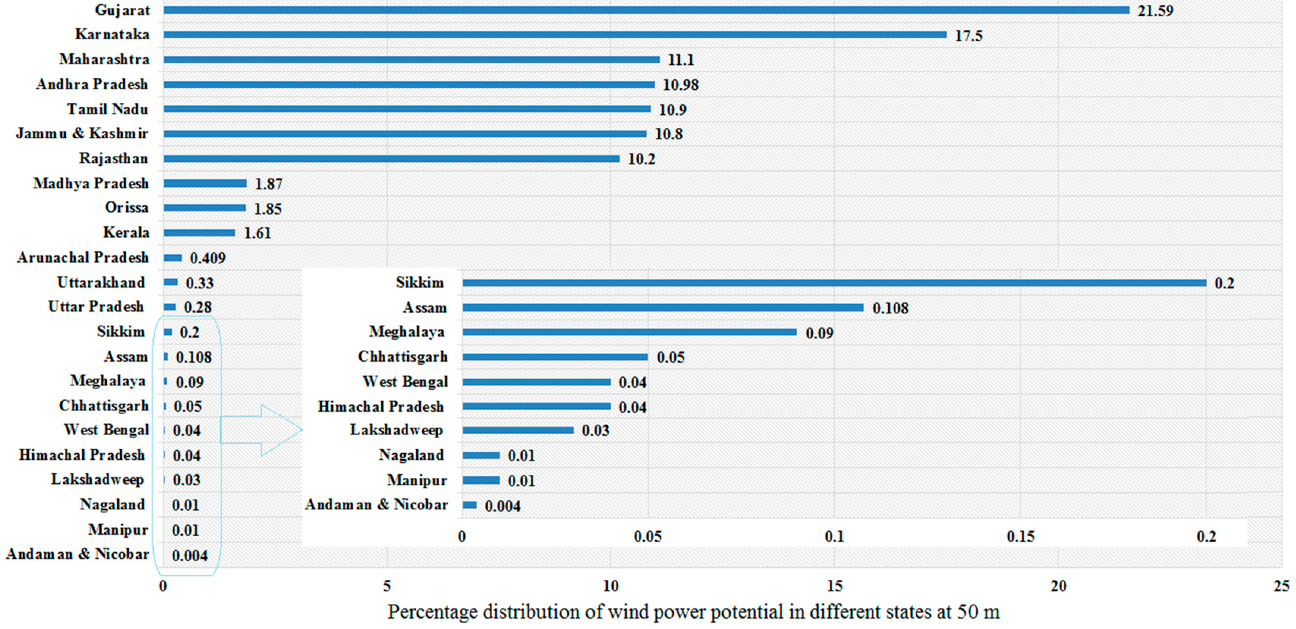
Figure 11. Percentage distribution of wind power potential in different states at 50 m AGL